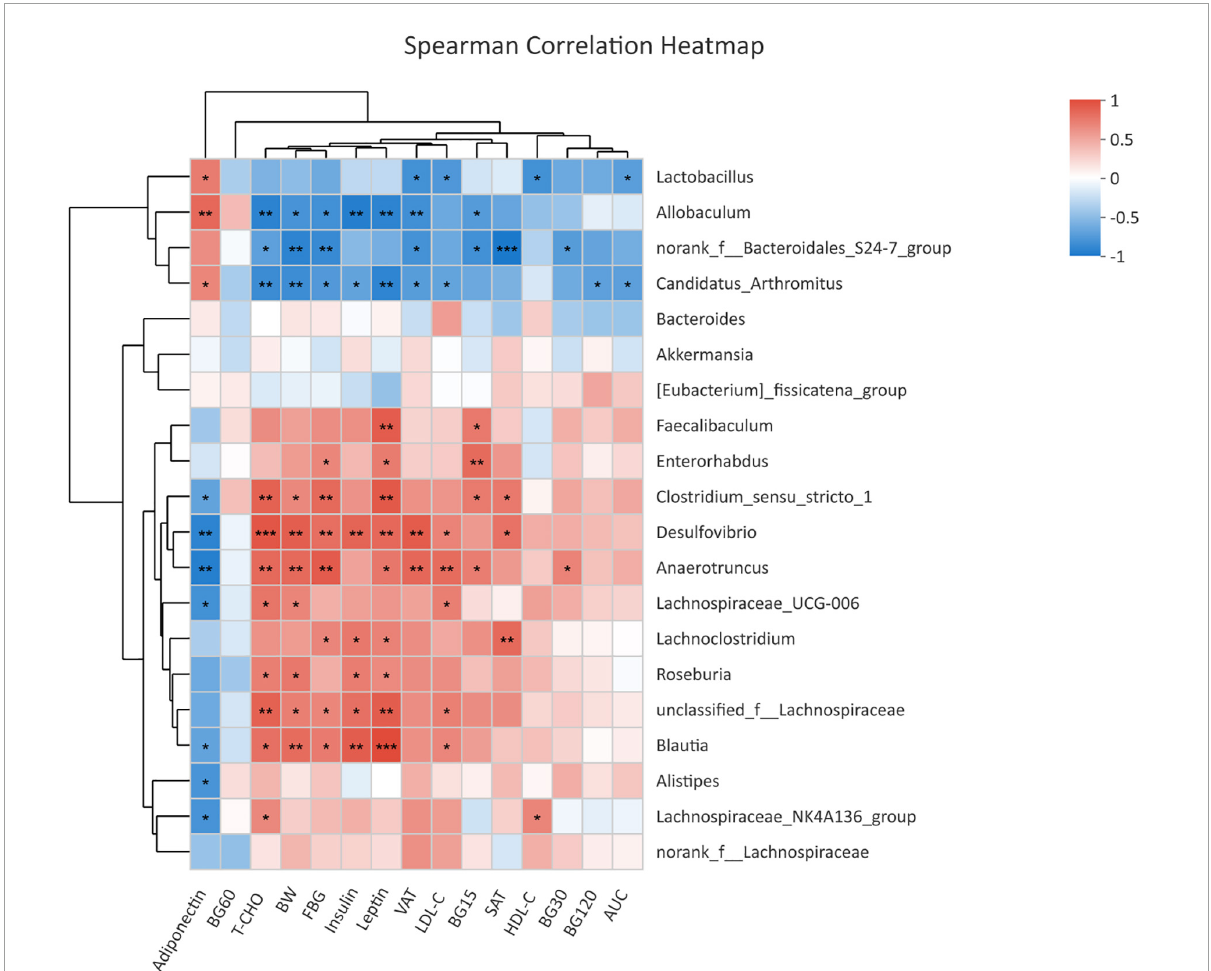
FIGURE4 Heatmap of correlation analysis between the differential genera and glycolipid profiles in offspring at weaning. Heatmap of correlation analysis of offspring at weaning (NC-3w, n = 6; HF-3w, n = 6). * p < 0.05, ** p < 0.01, *** p < 0.001 vs. NC-3w. NC, normal chow diet; HF, high-fat diet. BW, body weight; FBG, fasting blood glucose; BG15, blood glucose level at 15 min of IPGTTs; BG30, blood glucose level at 30 min of IPGTTs; BG60, blood glucose level at 60 min of IPGTTs; BG120, blood glucose level at 120 min of IPGTTs; AUC: the area under the glucose